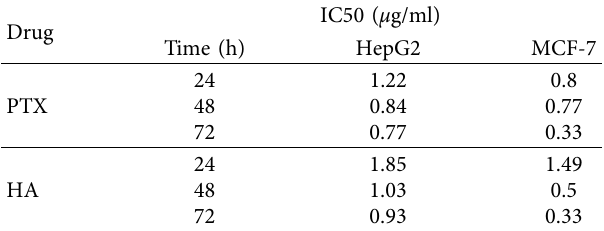
Figure 2: In vitro release of paclitaxel nanoparticles.